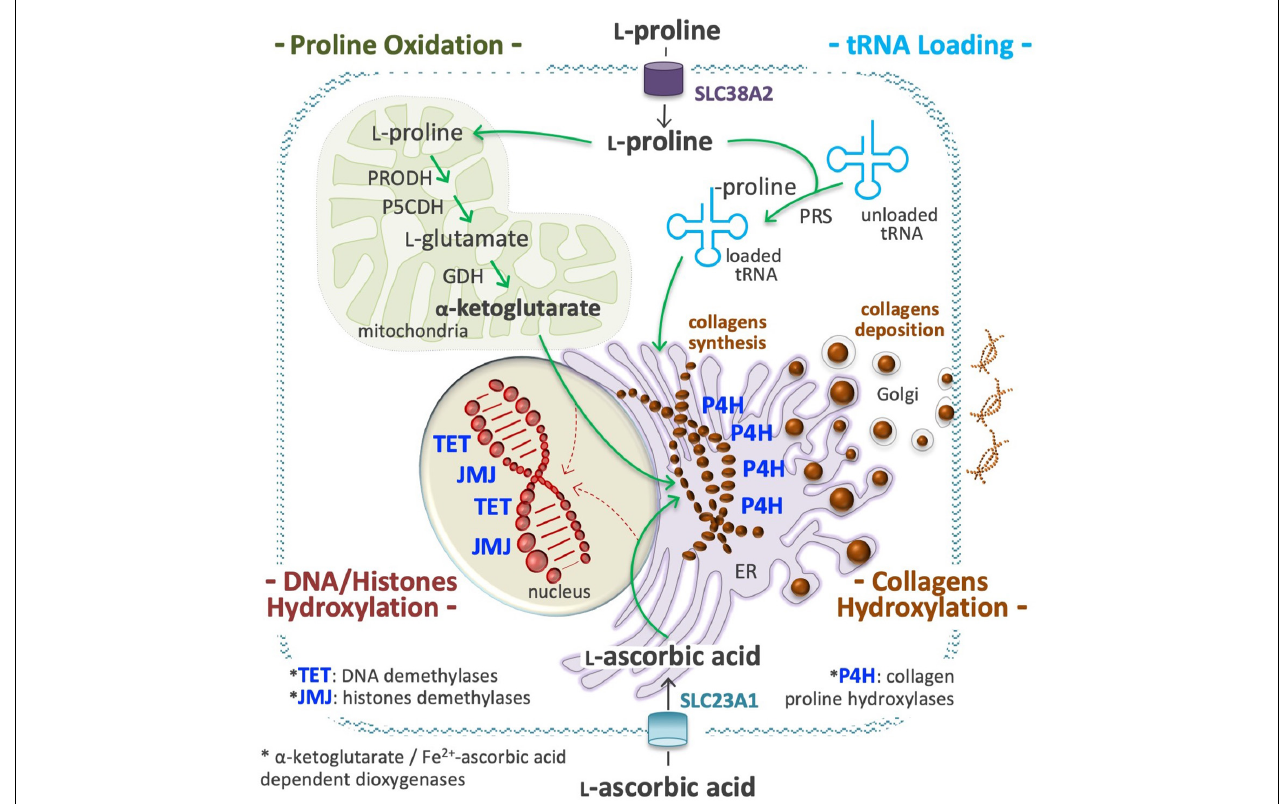
FIGURE 7 | Proline is an epigenetic modifier. At a high proline regimen, extracellular proline is channeled into the cell cytoplasm through a transport system, as the solute carrier family 38 member 2 (SLC38A2), also known as system N amino acid transporter 2 (SNAT2), and used to charge tRNA molecules ( top right ) , in a reaction catalyzed by the prolyl-tRNA synthetase (PRS). A high level of charged Proline-tRNA is an essential requisite for collagens synthesis ( middle ) . A high fraction of L -Pro residues of the nascent molecules of collagens are hydroxylated by prolyl 4-hydroxylases (P4H 1, 2, 3) dioxygenases enzymes, a process that consume huge amounts of ascorbic acid (vitamin C, VitC) and α -ketoglutarate ( α -KG) ( middle right ) . VitC is transported by members of the solute carrier family 23 (SLC23A1, 2; bottom ), whereas α -KG is produced inside mitochondria using proline and/or glutamate as precursors ( top left ) . A sudden and sizeable increment of P4H activity in the endoplasmic reticulum (ER) can reduce the availability of VitC and α -KG for the activity of nuclear dioxygenases involved in DNA methylcytosine hydroxylation/demethylation (ten-eleven translocation, TET 1, 2, 3) and in histones lysine hydroxylation/demethylation (jumonji, JMJ) ( bottom left ) . This compartmentalized metabolic perturbation, by increasing the DNA and histones methylation levels, can modify the epigenetic landscape of the